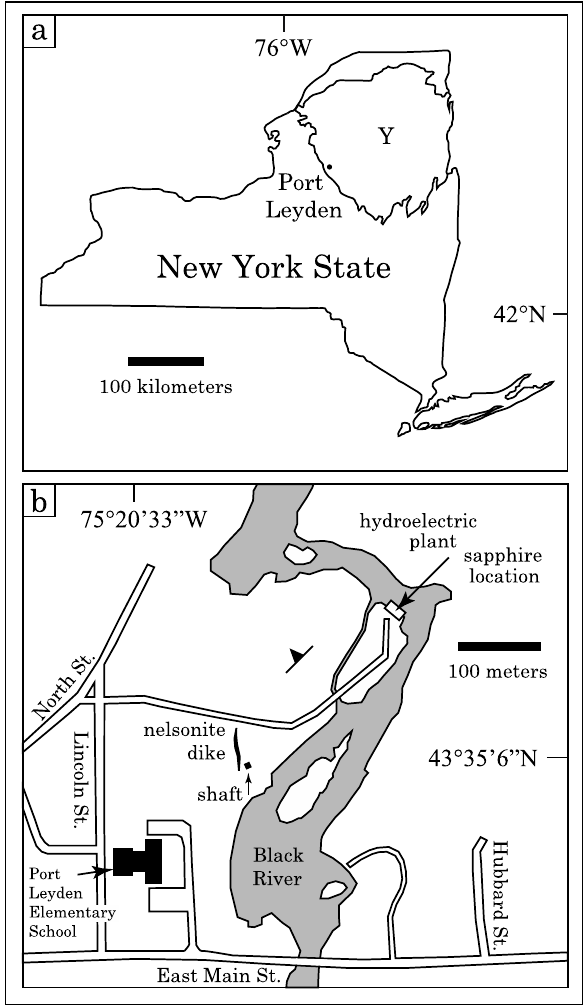
Figure 1. ( a ) Location map showing Middle Proterozoic (Y) rocks of the Adirondack Mountains in upstate New York and the village of Port Leyden. ( b ) Map of the eastern part of the village of Port Leyden showing location of the Port Leyden nelsonite dike, the hydroelectric plant on the Black River where the sapphire-bearing nelsonite dike was extracted, and strike and dip direction of foliation in the surrounding metapelite gneiss.